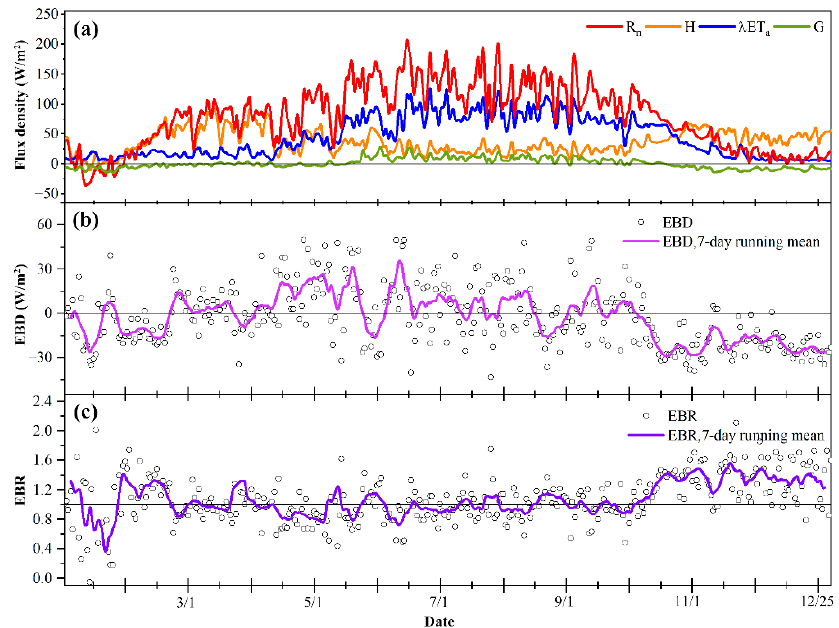
Figure 4. Variations in the ( a ) flux density at a height of 2 m, ( b ) energy balance deficit (EBD), and ( c ) energy balance ratio (EBR); the purple and pink solid lines represent 7-day running mean values, and others represent the daily mean value.